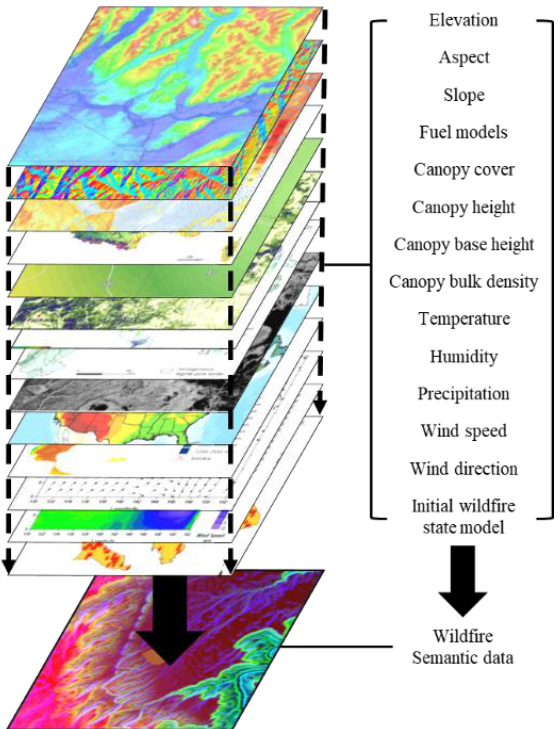
Figure 2. A disaster semantic data example for a wildfire.